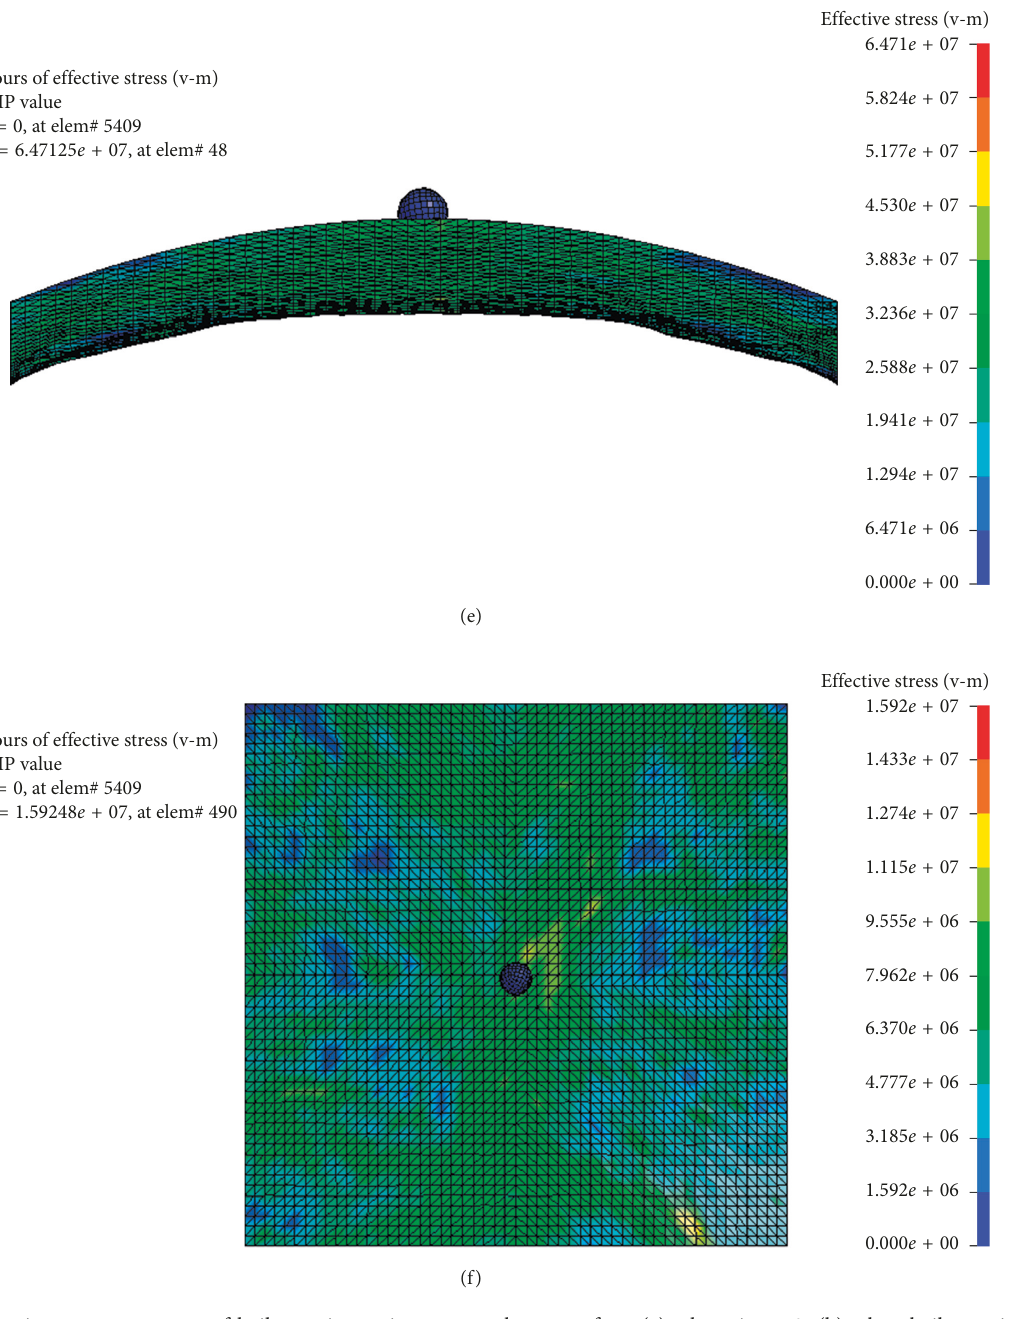
Figure 26: Dynamic response process of hailstone impacting on membrane surface: (a) when time � 0; (b) when hailstone impact on membrane surface; (c) and (d) when the displacement of the membrane is maximum; (e) and (f) when hailstone is bounced